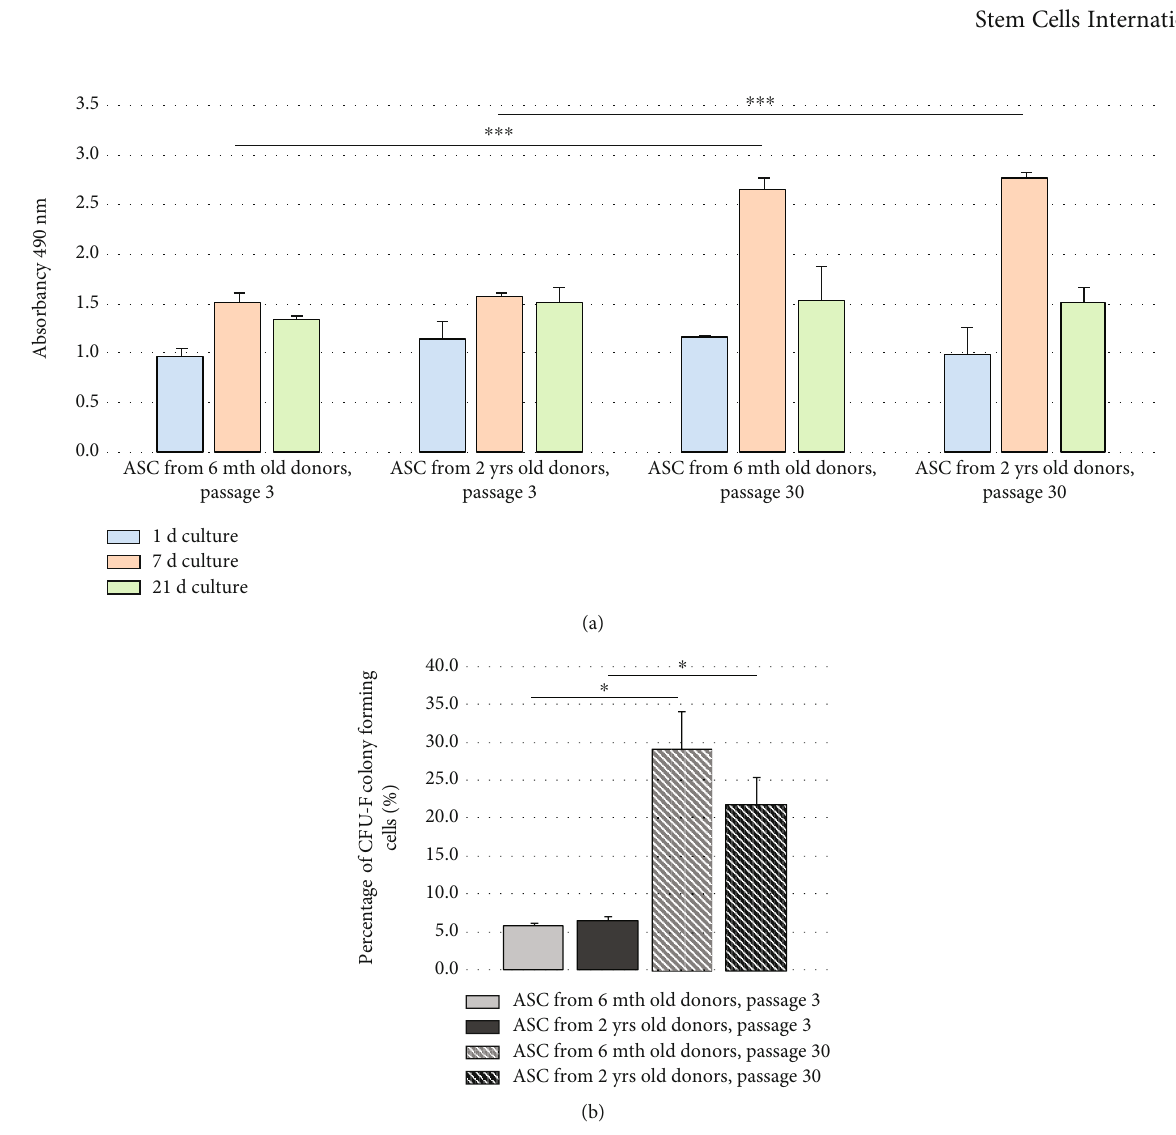
Figure 2: (a) ASC metabolic activity from passage 3 (p. 3) and passage 30 (p. 30) from donors aged 6mth and 2 yrs., respectively. 1, 7, or 21 d culture means the duration of MTS assay. ∗∗∗ p < 0 : 001 ; (b) clonogenic potential (CFU-F test) of ASCs from 6mth and 2yrs. donors, short- term (3 p.) and long-term (30 p.) in vitro culture. ∗ p < 0 : 05